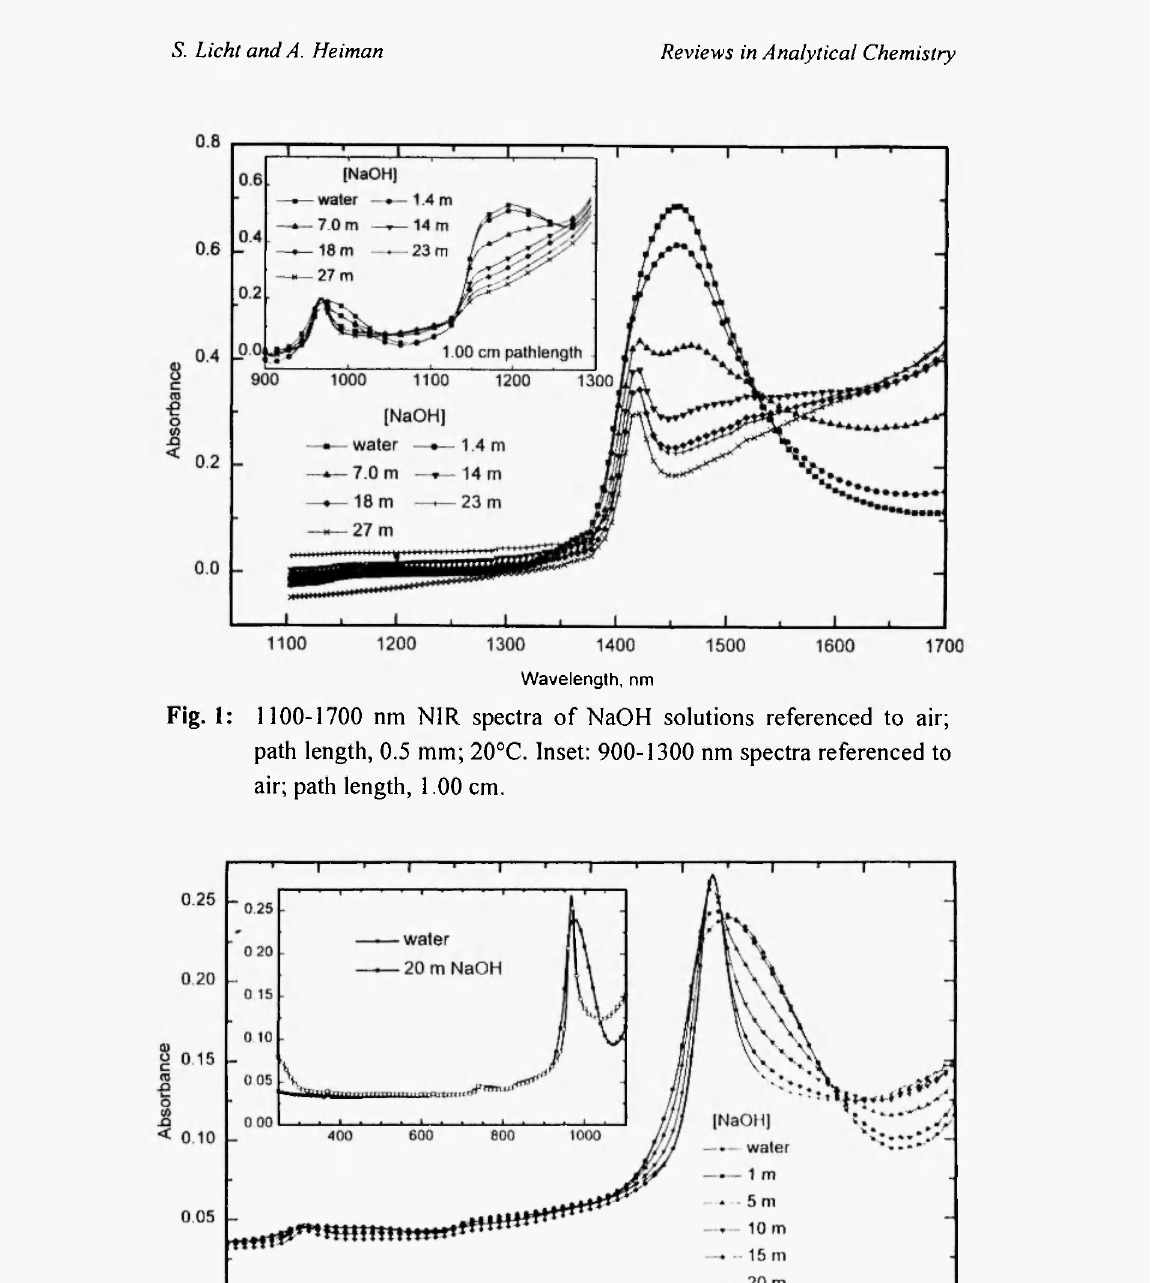
Fig. 2: Short-wave NIR spectra of NaOH solutions referenced to air; path length, 1.00 cm; 20°C. Inset: UV-SW NIR spectra of water and 20 m